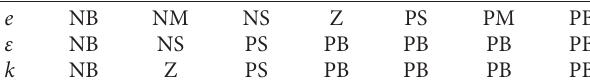
Figure 5: Flow chart of fuzzy SMC. Table 1: Fuzzy control rule table of parameters ε and k